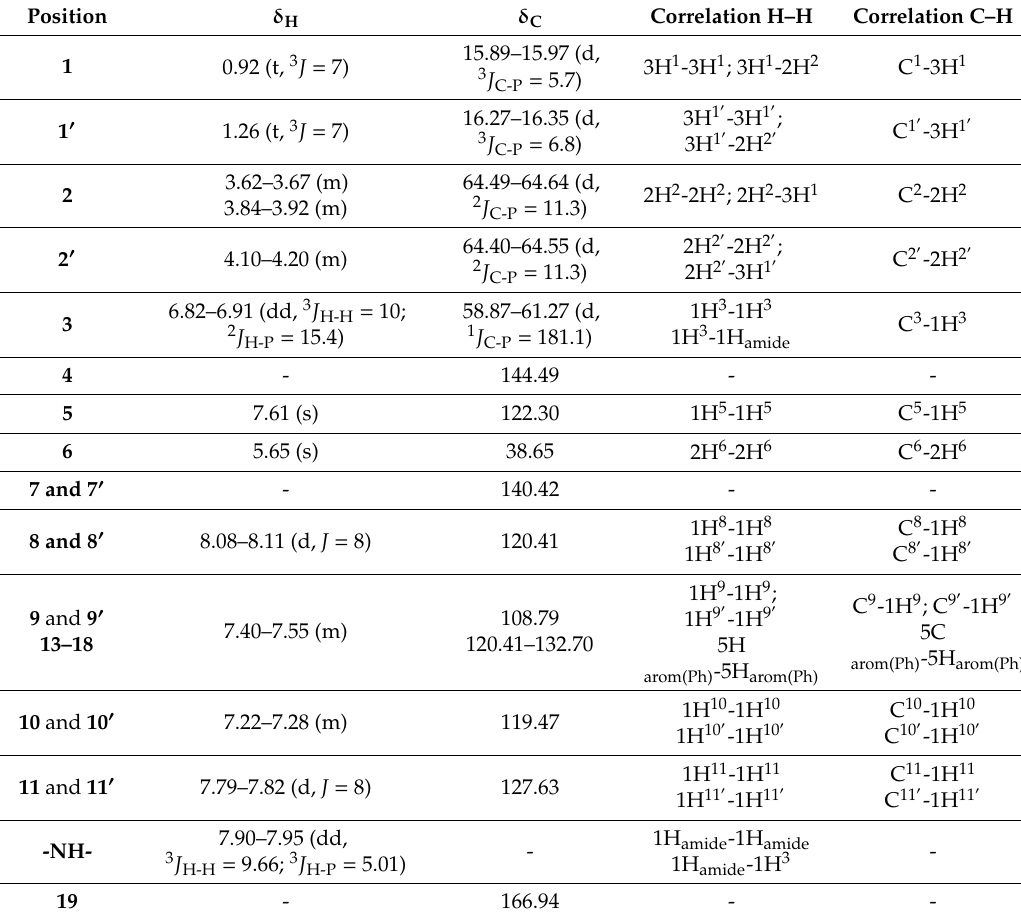
Table 1. 1 H (300 MHz) and 13 C (75 MHz) NMR spectral data for compound ( 3 ) in CDCl 3 , including results obtained by homonuclear 2D shift-correlated and heteronuclear 2D shift-correlated HMBC. Chemical shifts ( δ in ppm) and coupling constants ( J in